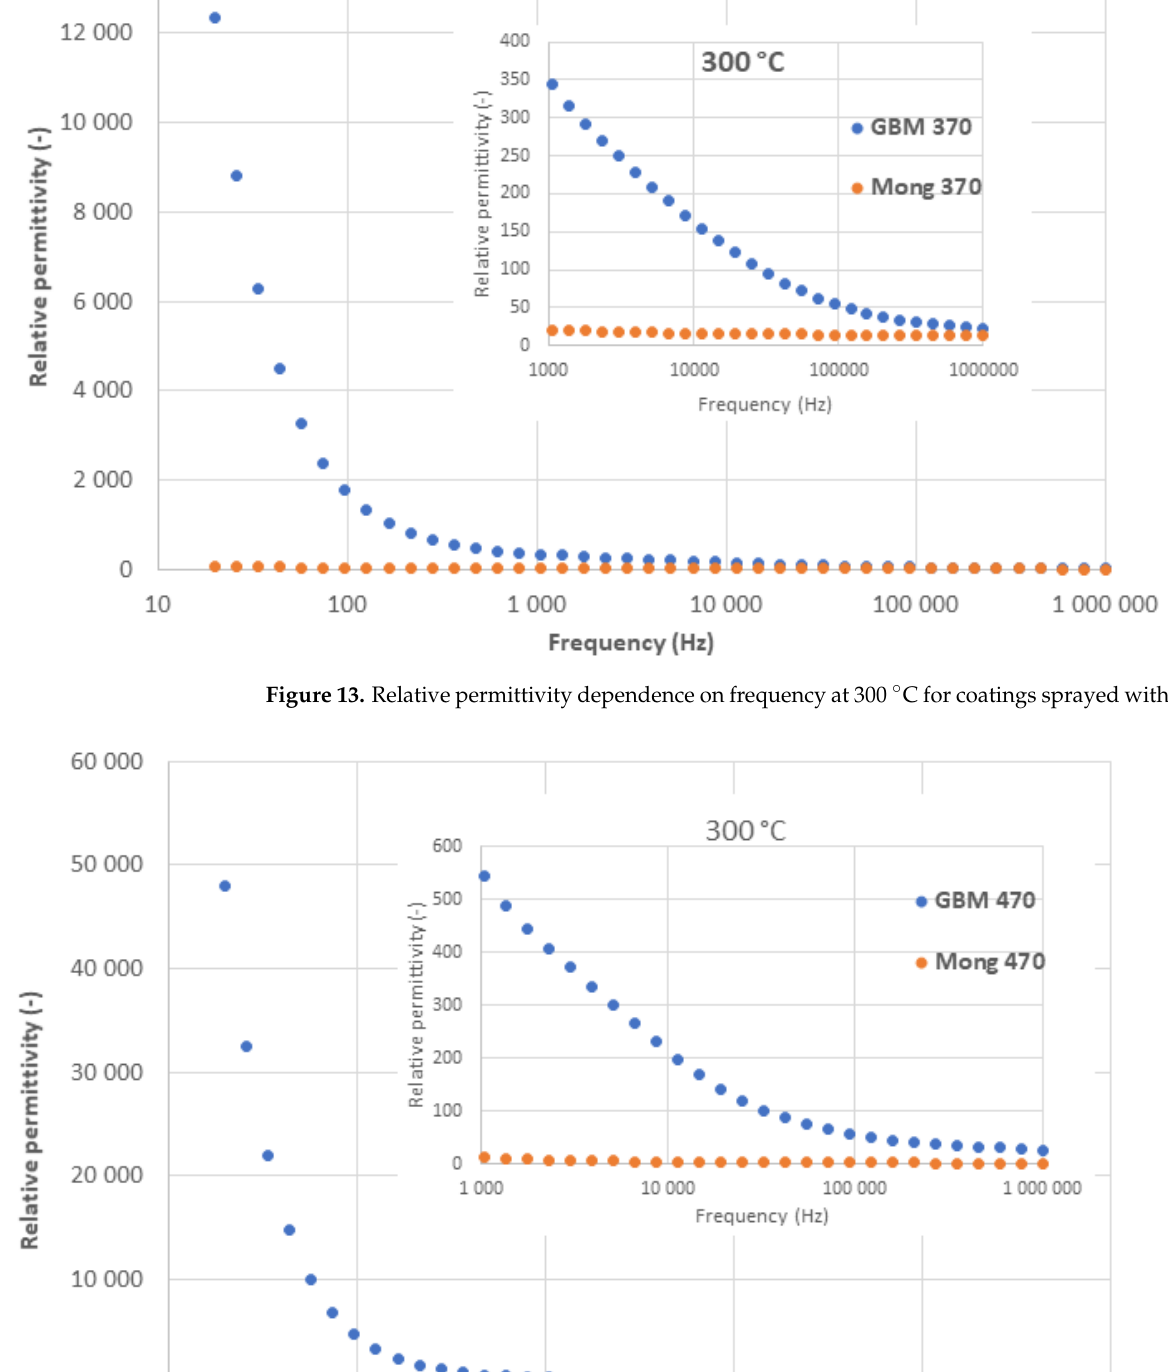
Figure 14. Relative permittivity dependence on frequency at 300 °C for coatings sprayed with SD 470.